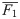
Box plots of errors of six estimation procedures aggregated over all language datasets.Errors are measured in terms of F1¯.